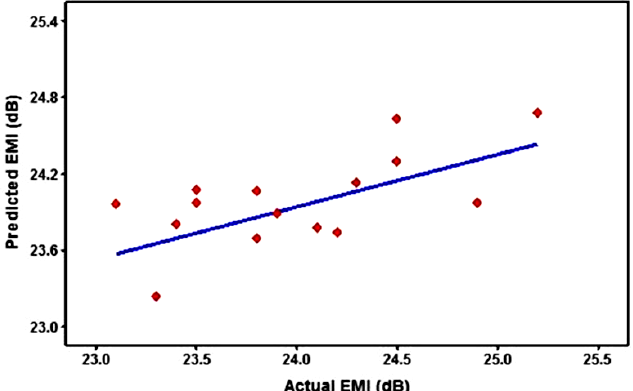
Figure 7. Actual vs. Predicted Electromagnetic Interference value. Table 9 and Figure 8 represent the optimal weight percent of GNP, ZrO 2 , and BC for the best EMI value through the RSM optimization study. It shows that the combination of 0.1 weight percent GNP, 0.5 weight percent ZrO 2 , and 2.5 weight percent BC provides the highest EMI SE data, i.e., 28.61 dB, with a desirability value of 1. Table 9. Optimum wt.% of graphite nanoplates, zirconium oxide and bamboo charcoal.